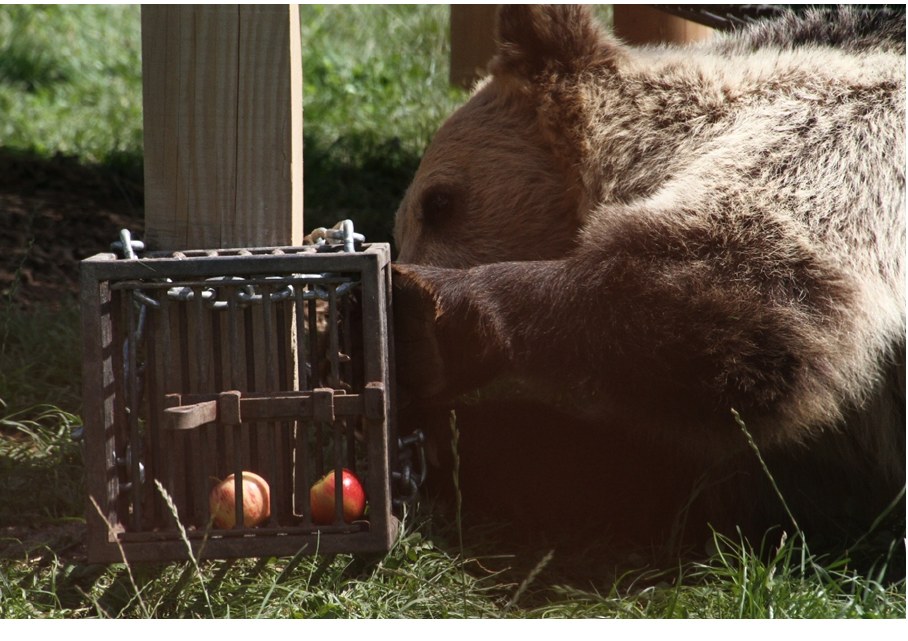
Bear Interacting with the Puzzle Box. Photo credit: Page, 2021